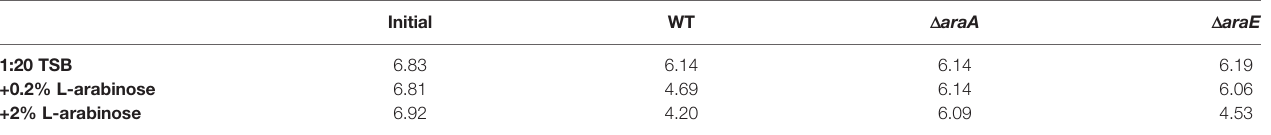
TABLE 1 | pH of the culture medium measured before bacterial inoculation (initial) and after the bacterial culture reached logarithmic growth for WT, D araA , and D araE in 1:20 TSB, +0.2% L-arabinose, and +2% L-arabinose. Initial WT D araA D araE